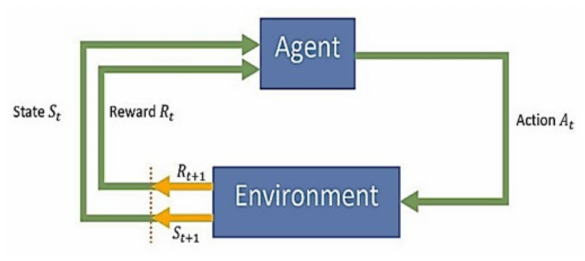
Figure 3. Flow of reinforcement